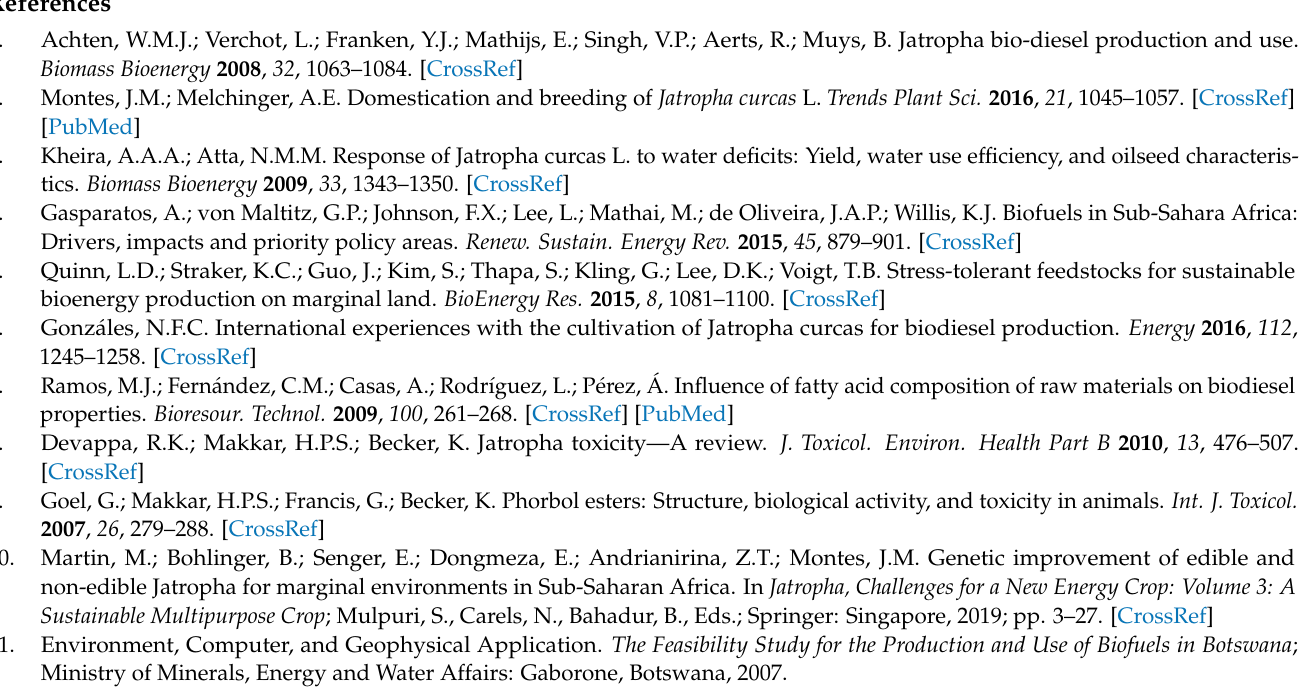
Table S10: Statistical summary on the seed traits of indigenous Jatropha accessions in Botswana, Table S11: Eigenvalues computed by the Horn’s parallel analysis, Table S12: PC scores of Jatropha indigenous accessions in